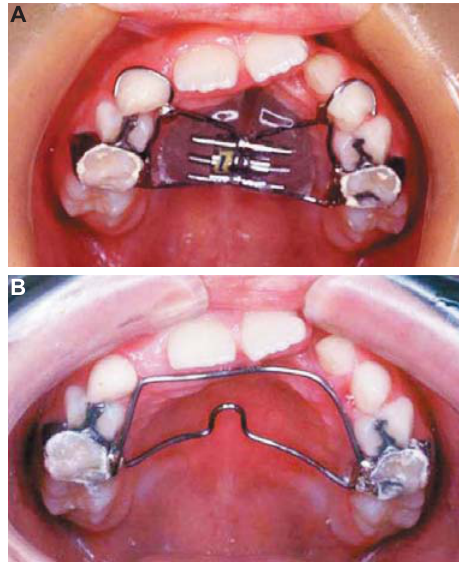
Figure 3- A- Haas type expander used for correcting (cid:2)(cid:3)(cid:4)(cid:5)(cid:2)(cid:6)(cid:7)(cid:8)(cid:9)(cid:10)(cid:4)(cid:6)(cid:9)(cid:7)(cid:11)(cid:5)(cid:12)(cid:4)(cid:13)(cid:14)(cid:15)(cid:4)(cid:8)(cid:14)(cid:16)(cid:5)(cid:17)(cid:18)(cid:5)(cid:2)(cid:3)(cid:4)(cid:5)(cid:19)(cid:7)(cid:20)(cid:15)(cid:11)(cid:11)(cid:7)(cid:6)(cid:16)(cid:5)(cid:7)(cid:6)(cid:14)(cid:3)(cid:21)(cid:5) B- Fixed retainer used after rapid maxillary